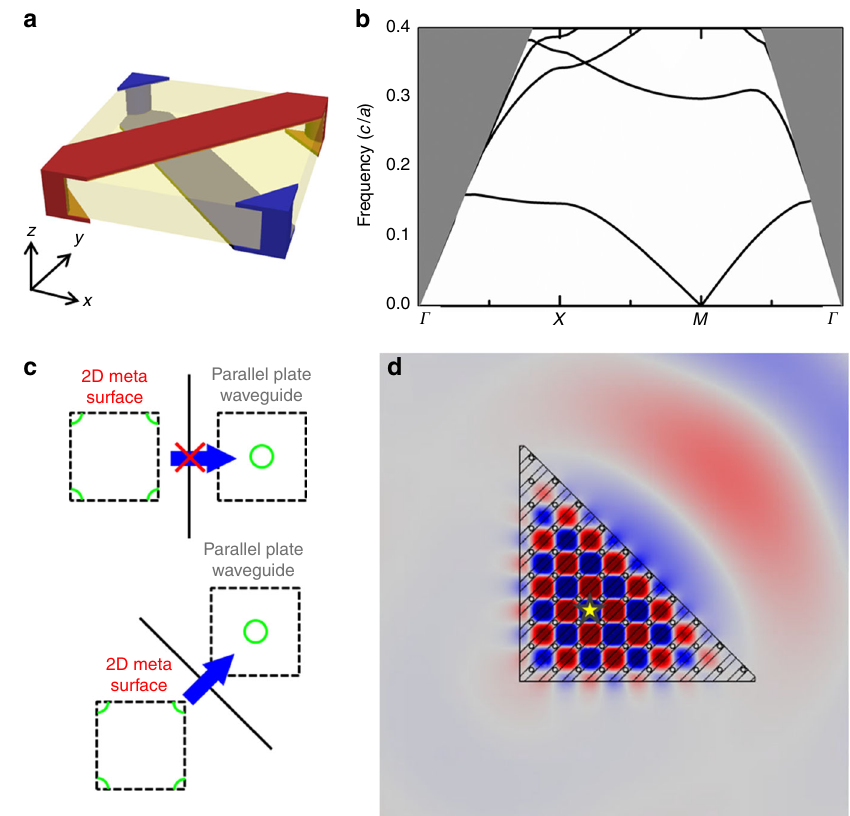
Fig. 5 Orientation-dependent coupling between a metasurface with a shifted index ellipse and ordinary materials. a Square unit cell of a 2D metasurface composed of metallic stripes (blue and red) printed on both sides of a dielectric substrate with ε = 4 (translucent yellow region). b Band structure of the metasurface showing an index ellipse centered at the M point. The gray area is the light cone. c Schematics of orientation-dependent transmission between the metasurface and a parallel plate waveguide, which serves as an ordinary material with a light cone at k = 0. When the interface between the two materials is perpendicular to the principal axis, the waves in metasurface cannot couple to the parallel plate waveguide. The electromagnetic wave can be transmitted through the interface when the interface is tilted at 45°. d Simulated fi eld pattern when a point source (yellow star) is embedded in the metasurface with a triangular boundary. The electromagnetic wave can only be coupled out through the upper right